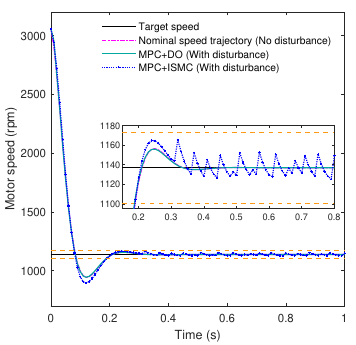
Figure 8. Speed synchronization performance with MPC + DO and MPC + ISMC